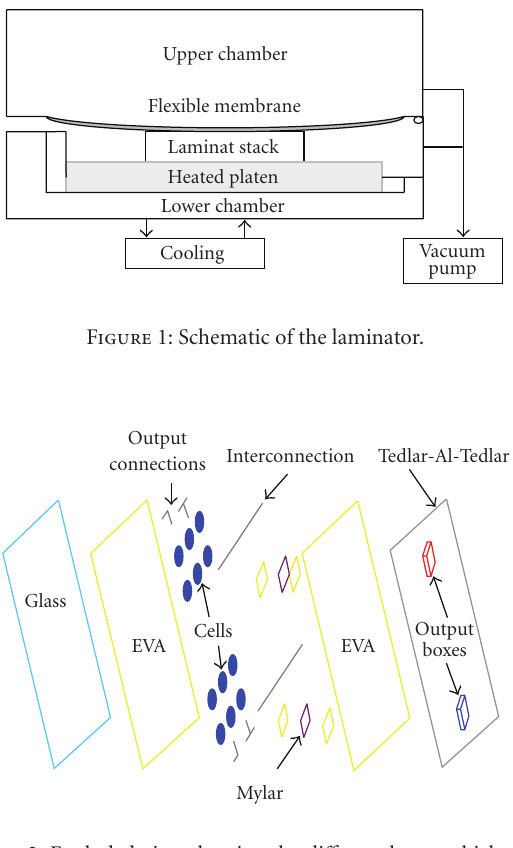
Figure 2: Exploded view showing the di ff erent layers which make up the module.